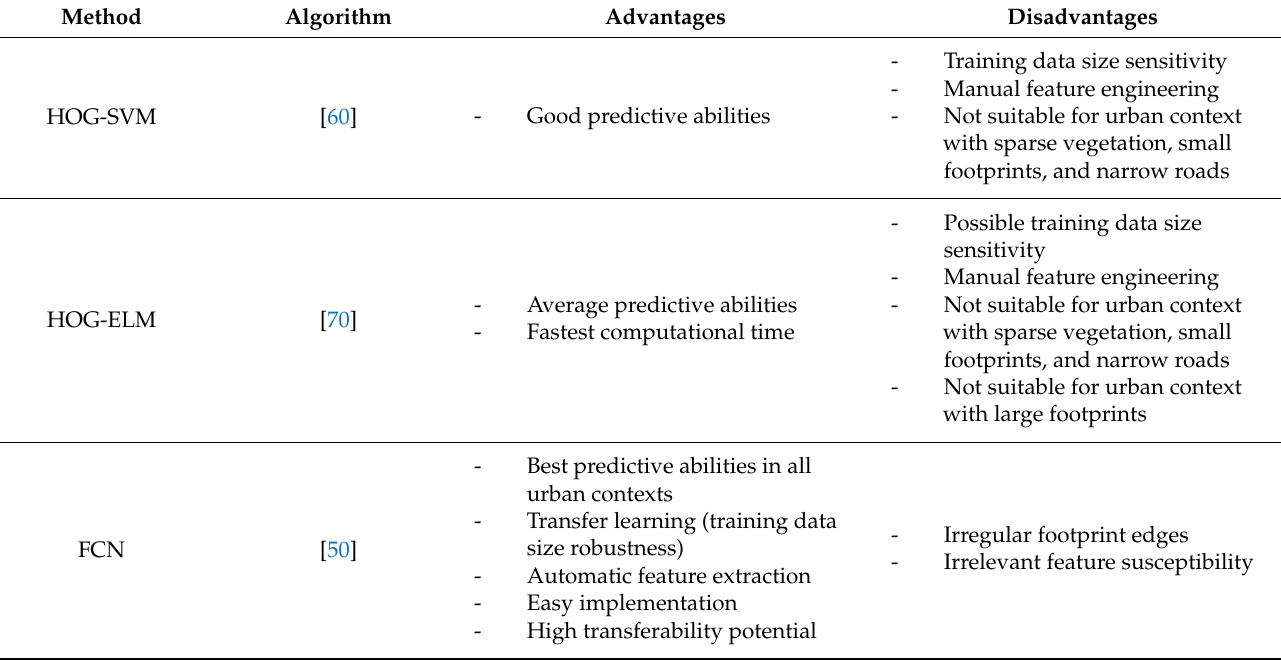
Table 2. Advantages and disadvantages of the three implemented methods.